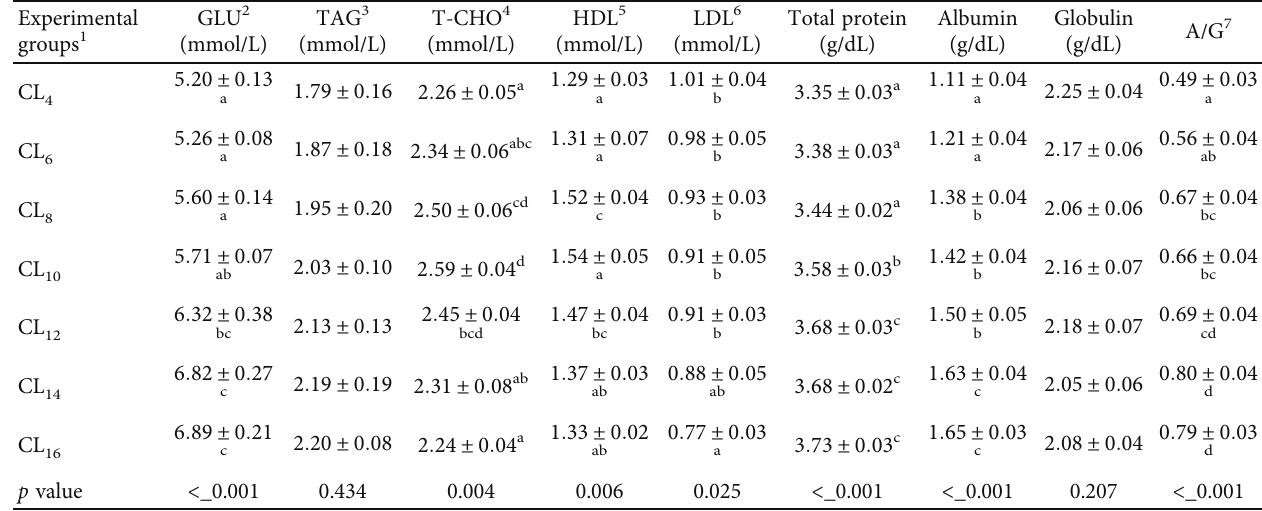
Table 6: Serum glucose, lipid, and protein pro fi le of GIFT juveniles cultured in IGSW of 15ppt and fed with experimental diets for 60 days. Experimental groups 1